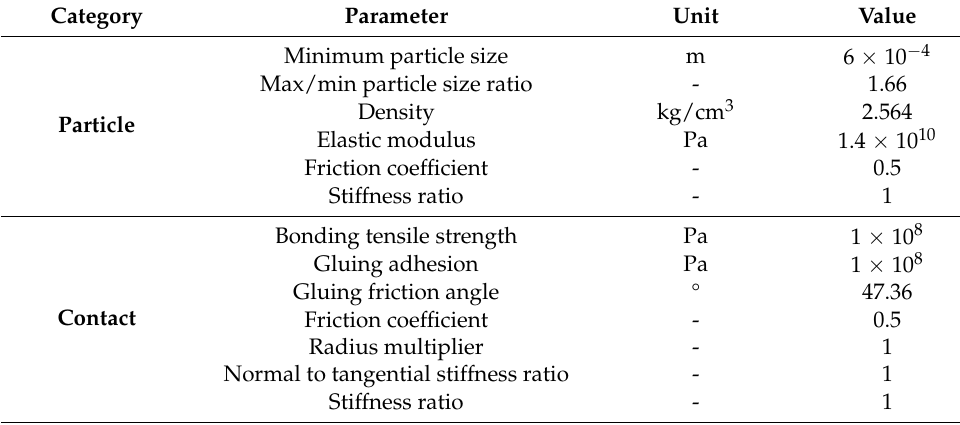
Table 3. Parameters of the particle and the contact.